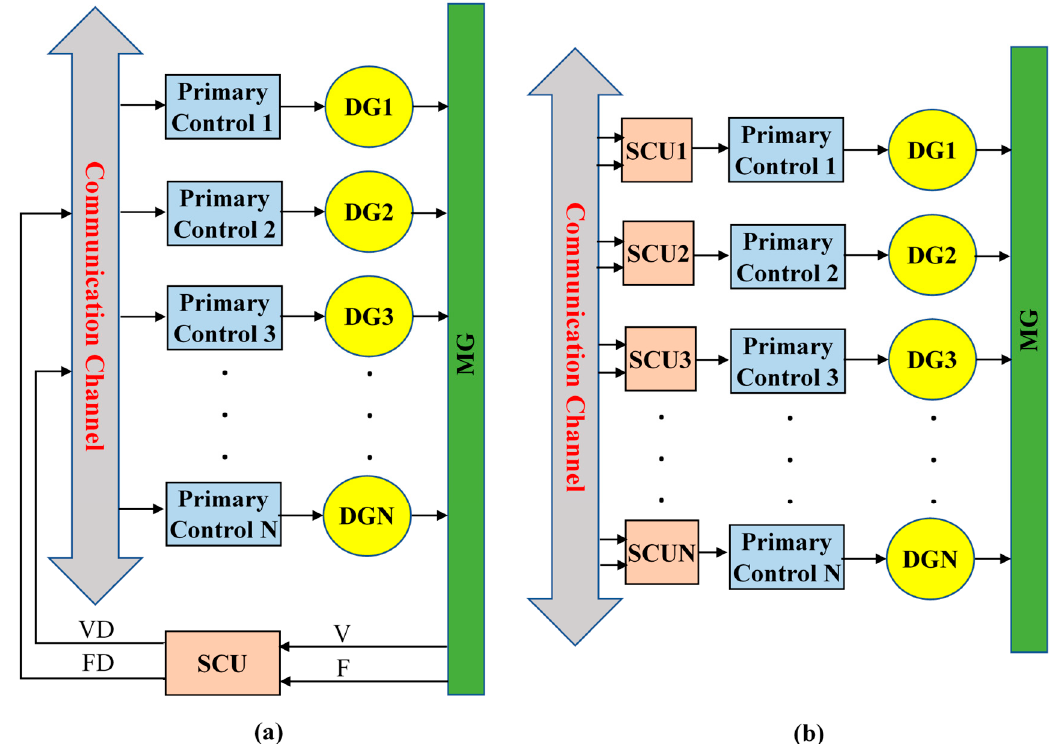
Figure 1. ( a ) Centralized and ( b ) decentralized secondary control strategies.